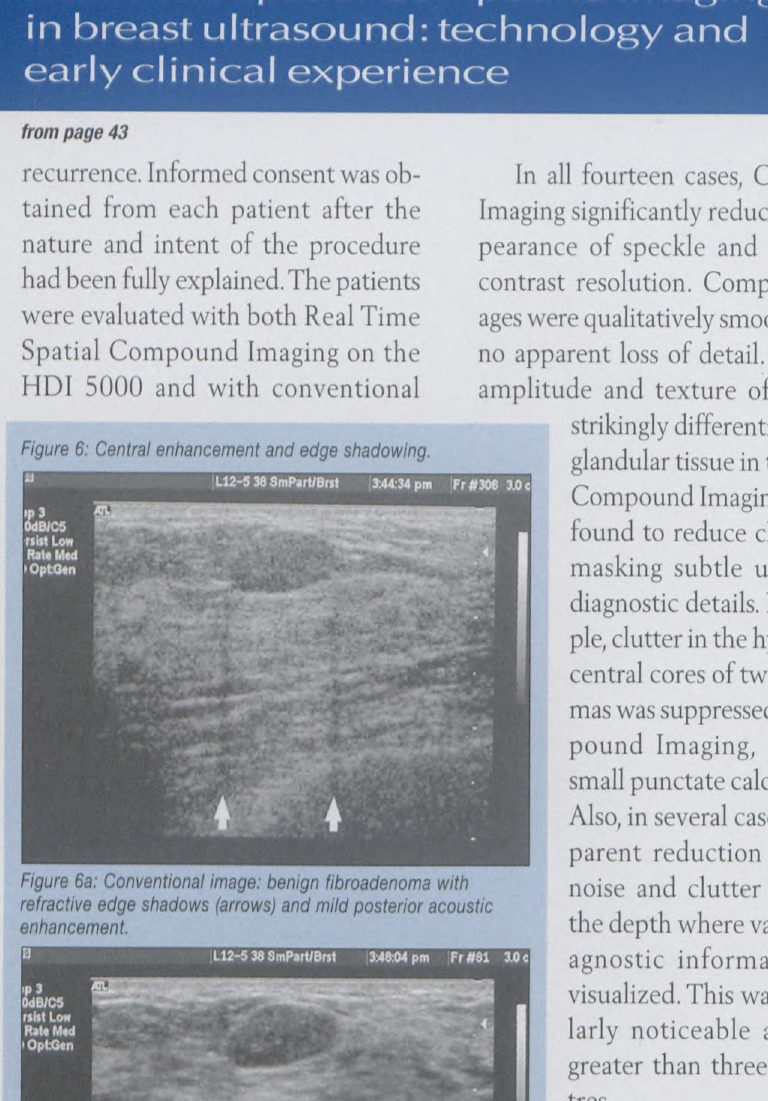
Figure 6a: Conventional image: benign fibroadenoma with refractive edge shadows (arrows) and mild posterior acoustic enhancement.